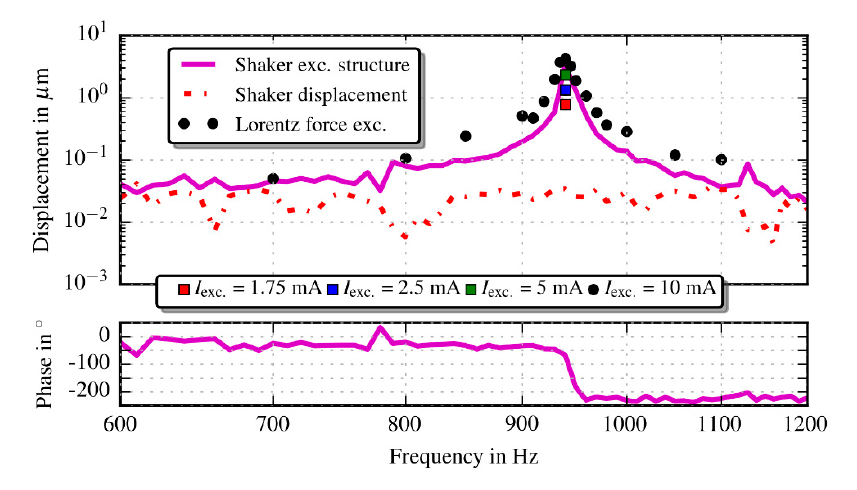
Figure 4. The plot depicts both, the transducer’s mechanical- and the shaker’s transfer characteristic. Different applied excitation currents at resonance demonstrate the transducer’s linear